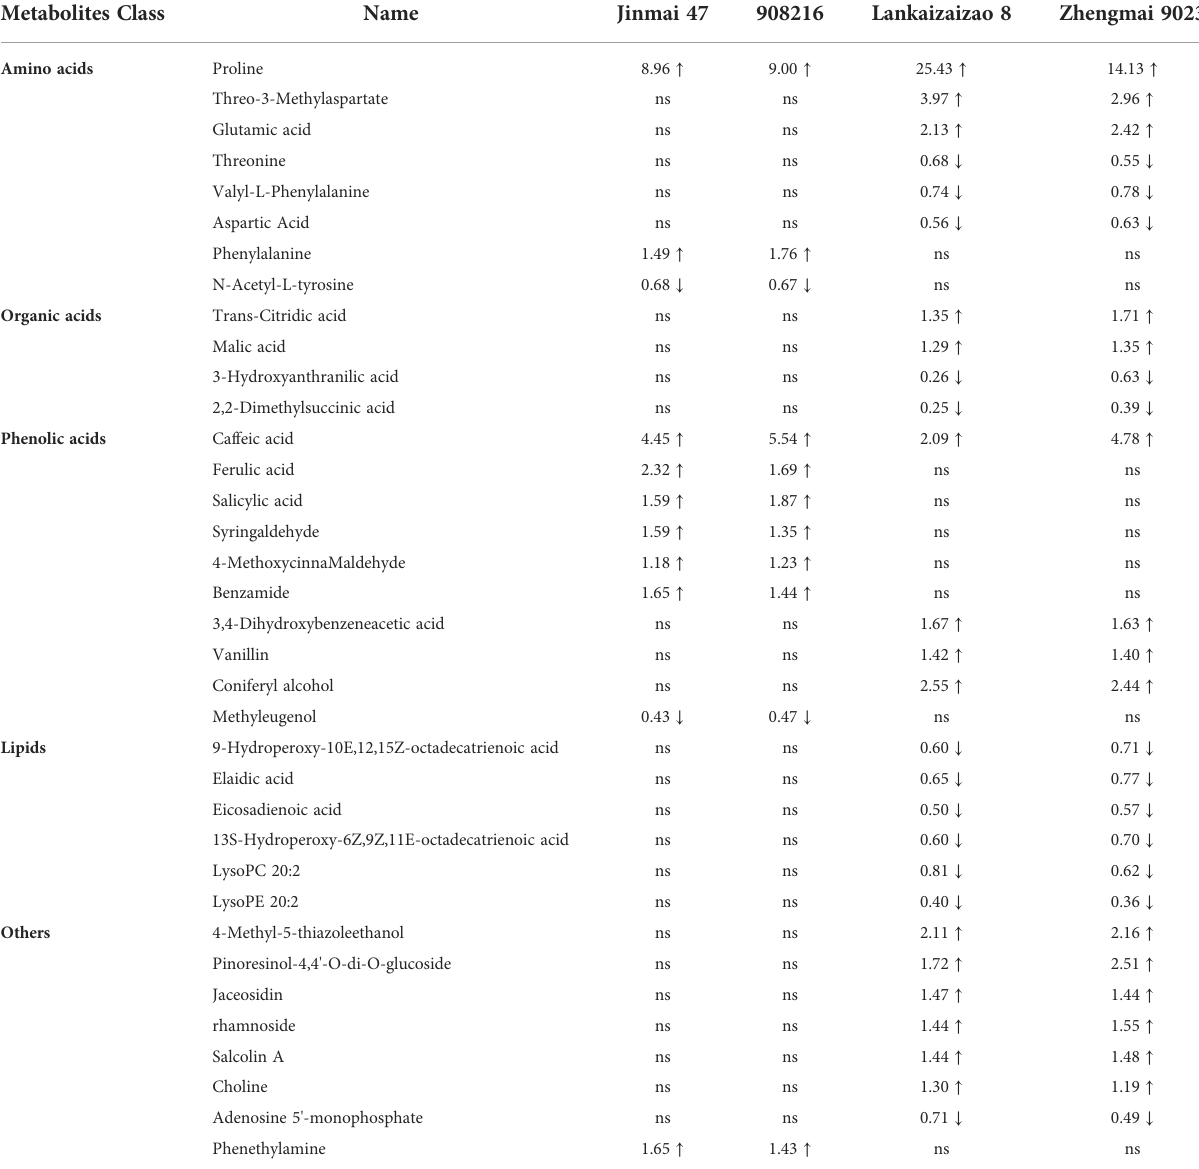
TABLE 2 Fold changes of the important metabolites differing between the drought tolerant dryland genotypes Jinmai 47 and 908216 and the drought sensitive irrigated genotypes Landkaoaizao and Zhengmai 9023 in response to drought stress. Metabolites